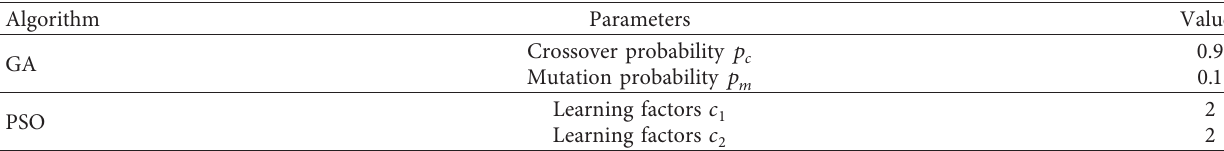
Figure 6: RMSE of the optimized ELM models. Table 2: Parameters of algorithms.